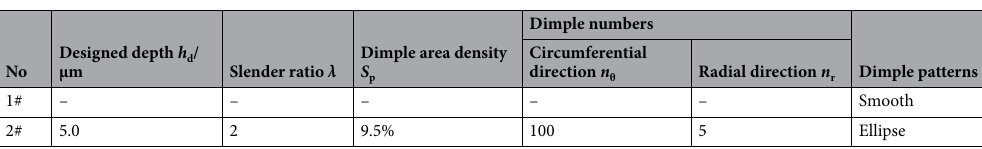
Table 1. Meanings and dimensions of different geometrical parameters of elliptical dimples on rotor